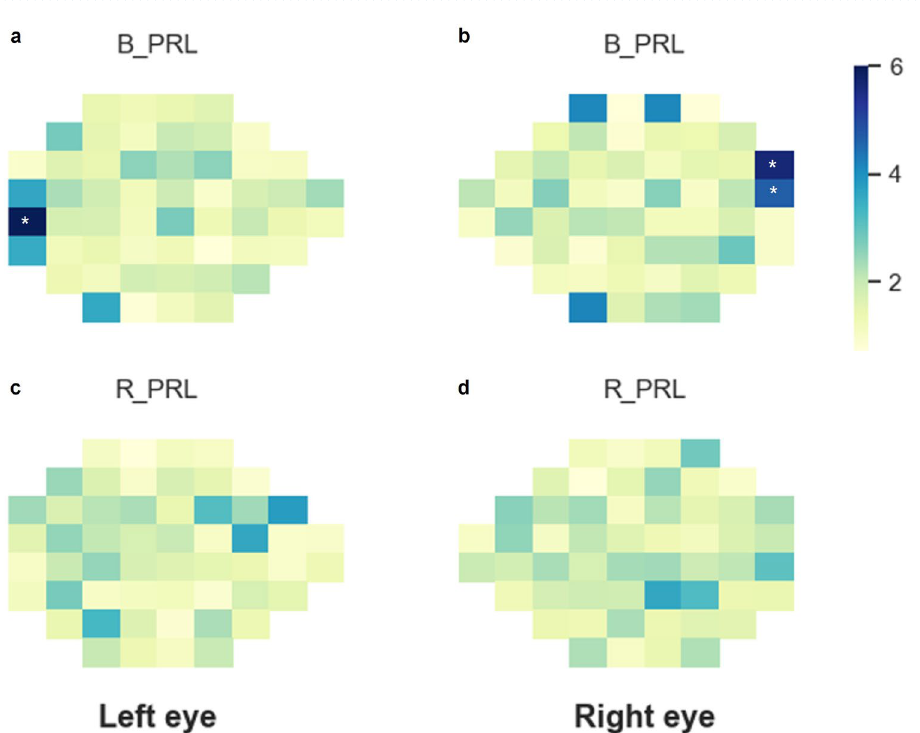
Figure 2. The relative weight given by the machine-learning model to each one of the 54 retinal test-targets for Pupil Response Latency (PRL) in the left ( a , c ) and right eye ( b , d ) for dim blue ( a , b , B_PRL) and dim red light stimuli ( c , d , R_PRL). The weights were averaged over the 2000 trials that were used to produce the 95% CI, as depicted in Fig. 6. Color-coding indicates higher weights in darker colors. White asterisks indicate the targets with highest weight for the dim blue light ( a , b